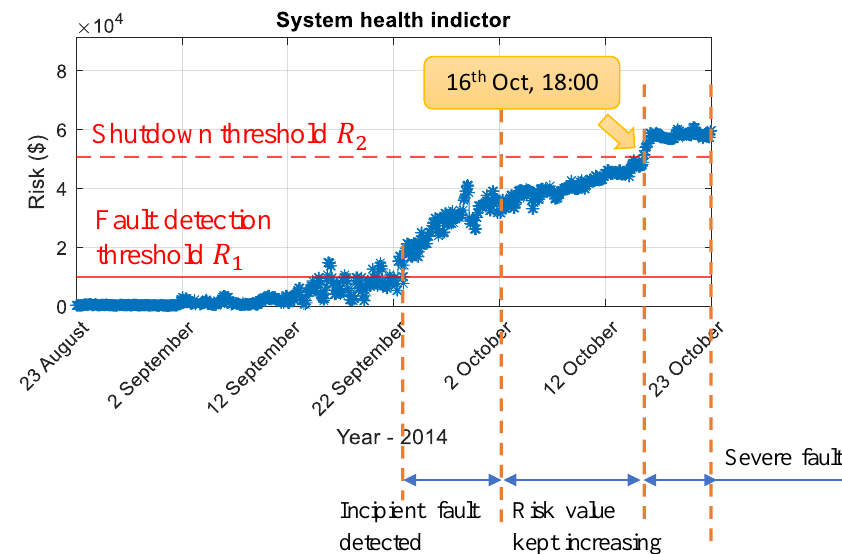
Figure 20. System health indicator presented by risk profile of the compressor. In this case, the health indicator detected the fault during 22 September to 2 October 2014. Compared to the measured variables obtained from the compressor’s condition monitoring system in Figure 21, during this time, only slight changes appeared in the measurements of the compressor. This indicated that the health indicator successfully detected the fault at its incipient stage.